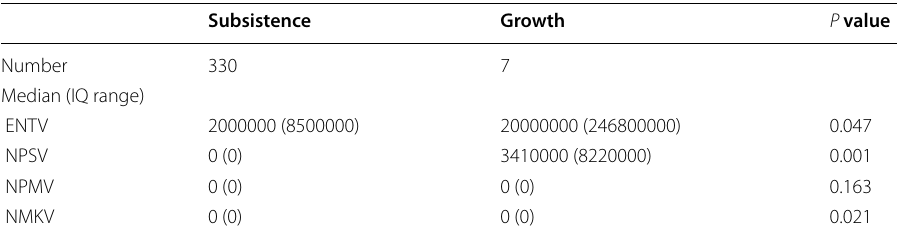
Table 10 Differences between subsistence enterprises and growth-oriented enterprises in the value of innovations carried